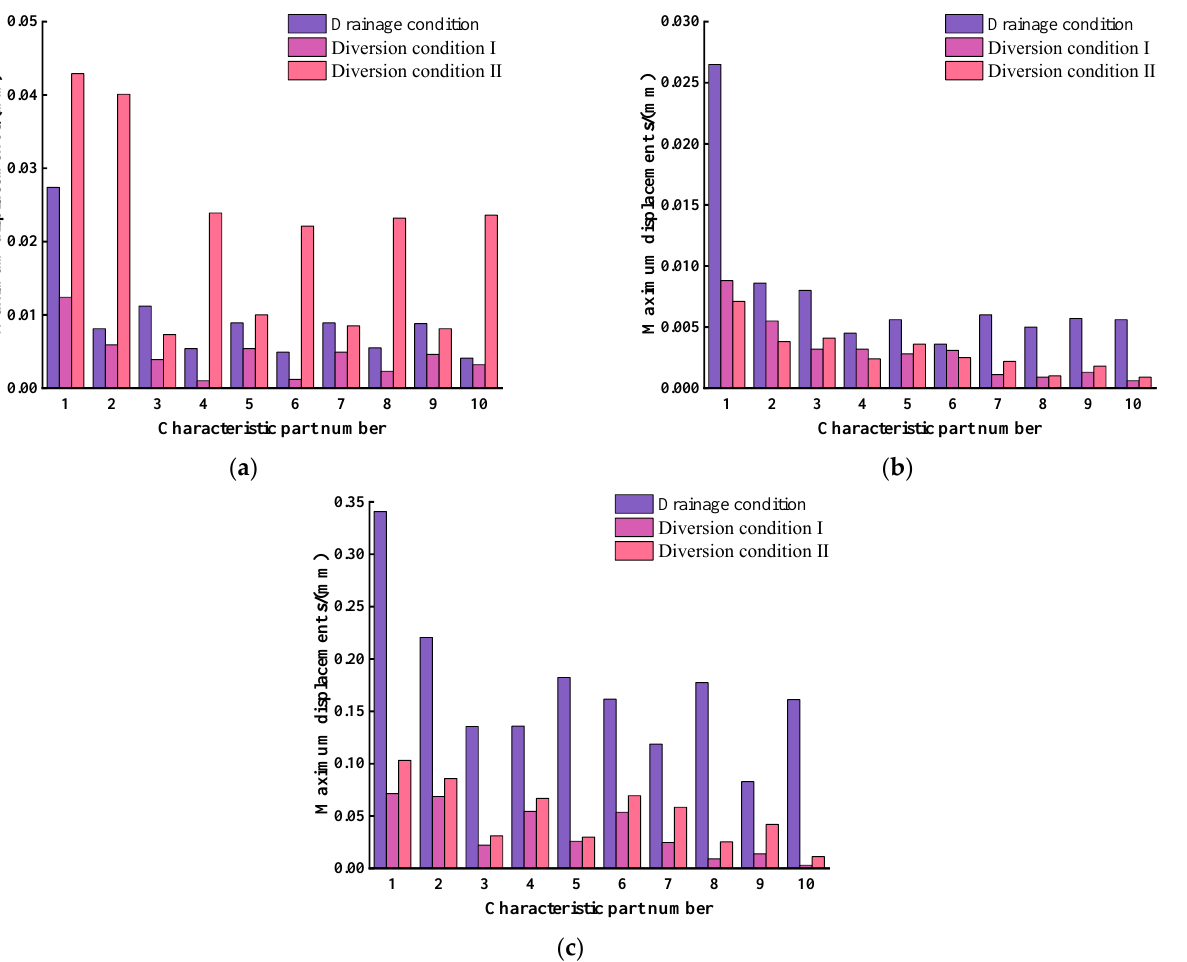
Figure 13. Maximum dynamic displacement of characteristic parts: ( a ) X -axis; ( b ) Y -axis; ( c ) Z -axis.